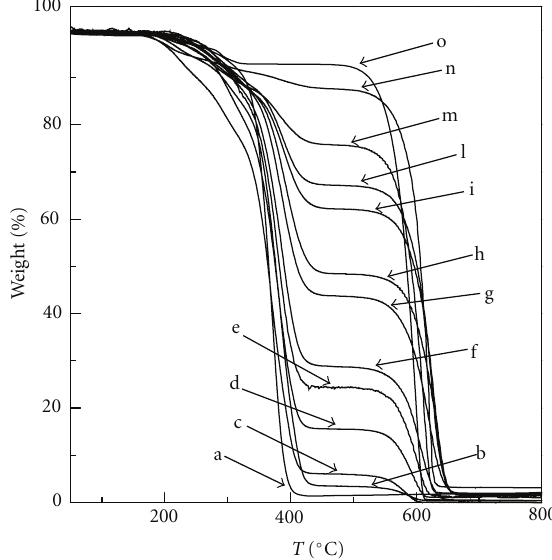
Figure 4: TGA curves at 10 ◦ C/min heating rate for various samples in nitrogen atmosphere: PMMA (a); BPM4 (b); BPM5 (c); BPM6 (d); BPM7 (e); BPM8 (f); BPM9 (g); BPM10 (h); BPM11 (i); BPM12 (l); BPM13 (m); BPM14 (n); BP44